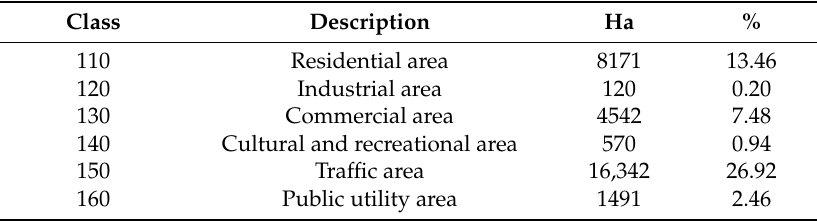
Figure 2. Seoul area (black thick curve), land use (color shading), and KMA/SKT AWSs (Korea Meteorological Administration; black solid triangle/open circle). Legend (right) shows land color codes indicating identical ground surface cover in an area. The black square is the Songpa area, which is our detailed spatial analysis area. A description of the legend is given in Table 1. Data source: Ministry of Environment (MOE, Korea). Table 1. Classification of ground surface covering and their respective